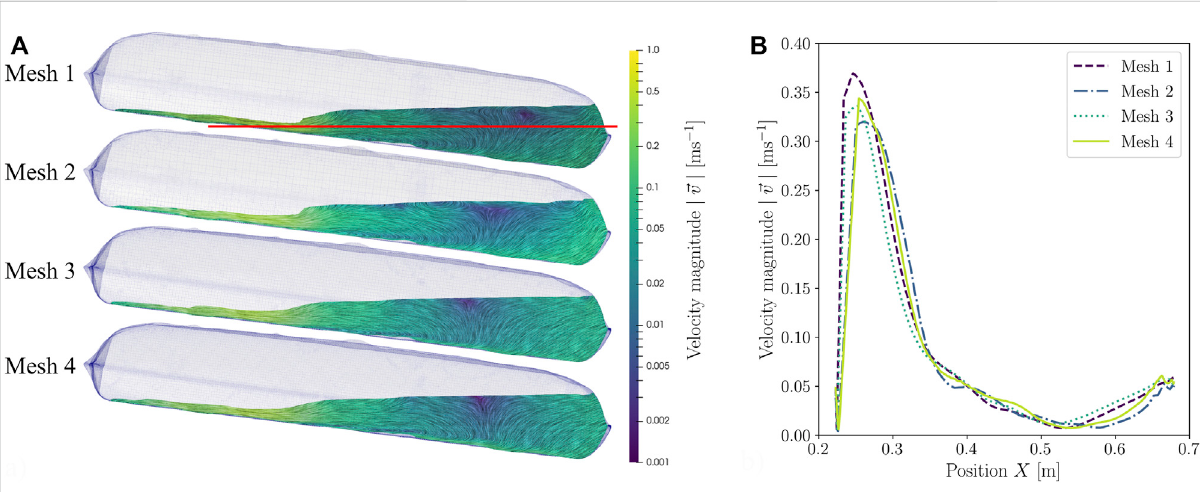
FIGURE 6 Comparison of (A) the fl uid fl ow of CFD simulations with different meshes and (B) the resulting fl uid velocities plotted over the red line in